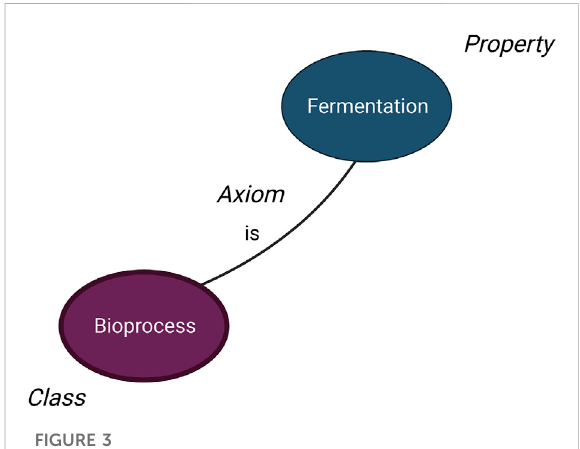
FIGURE 3 Schematic example of the different categories that compose an ontology. This fi gure shows that a fermentation (property) is (axiom) a bioprocess